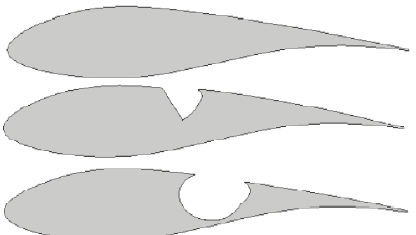
Figure 8. Geometries prepared for numerical simulation, from the top: standard Risø airfoil, airfoil with cavity A, airfoil with cavity B.